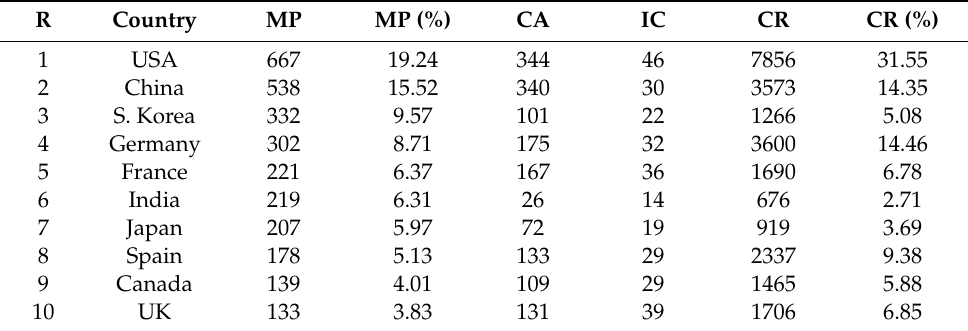
Table 1. Most productive countries in I2X, V2X, and P2X research from 1996 to 2018.